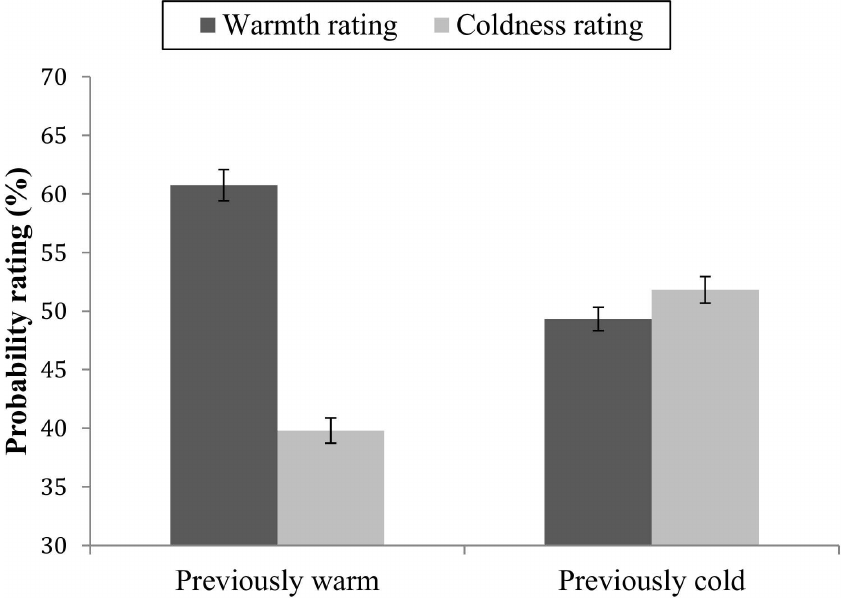
Fig 7. Mean probability ratings of future warm and future cold behaviors. Ratingsof targets with previously mainly warm or mainly cold behavior.Error bars represent standarderrors.